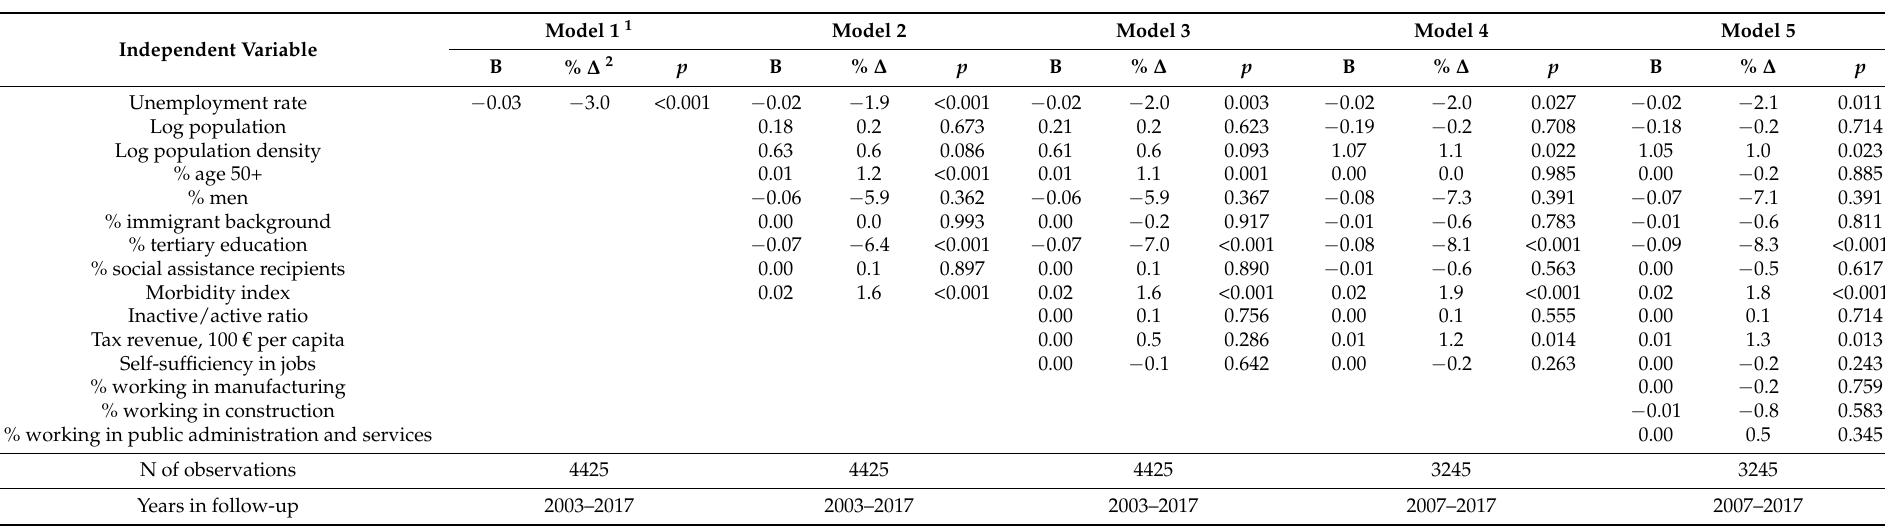
Table 4. Results on disability retirement (logged disability retirement rate as outcome). Fixed effects models on Finnish municipalities ( n = 295) over 15 years (2003–2017). Independent